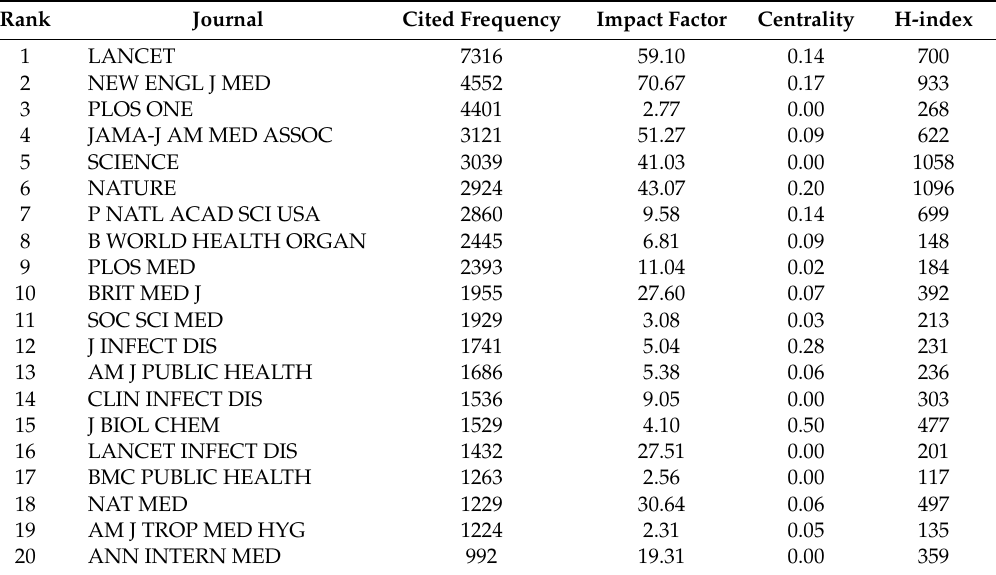
Figure 3. Visualization of co-citation journals. Table 1. The top 20 journals.